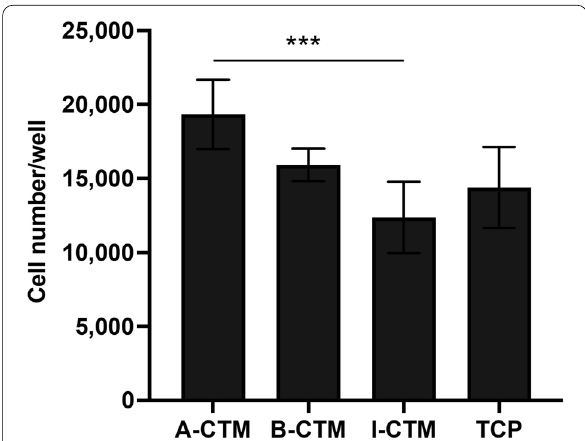
Fig. 1 Adhesion of tenocytes on connective tissue matrices. Ultra-low attachment plate wells were coated with A-CTM, B-CTM, or I-CTM. Tenocytes were seeded onto the coated wells and incubated for 24 h. The viabilities of cells were measured by alamarBlue assay and numbers of adherent cells were converted from a standard curve. Data shown are mean SD ( n 4). * p 0.05, ** p 0.01, ± = ≤ ≤ *** p 0.005). Abbreviations: A-CTM, AmnioFill ® connective tissue ≤ matrix; B-CTM, BioRenew ™ connective tissue matrix; I-CTM, Interfyl ® connective tissue matrix; TCP, tissue culture